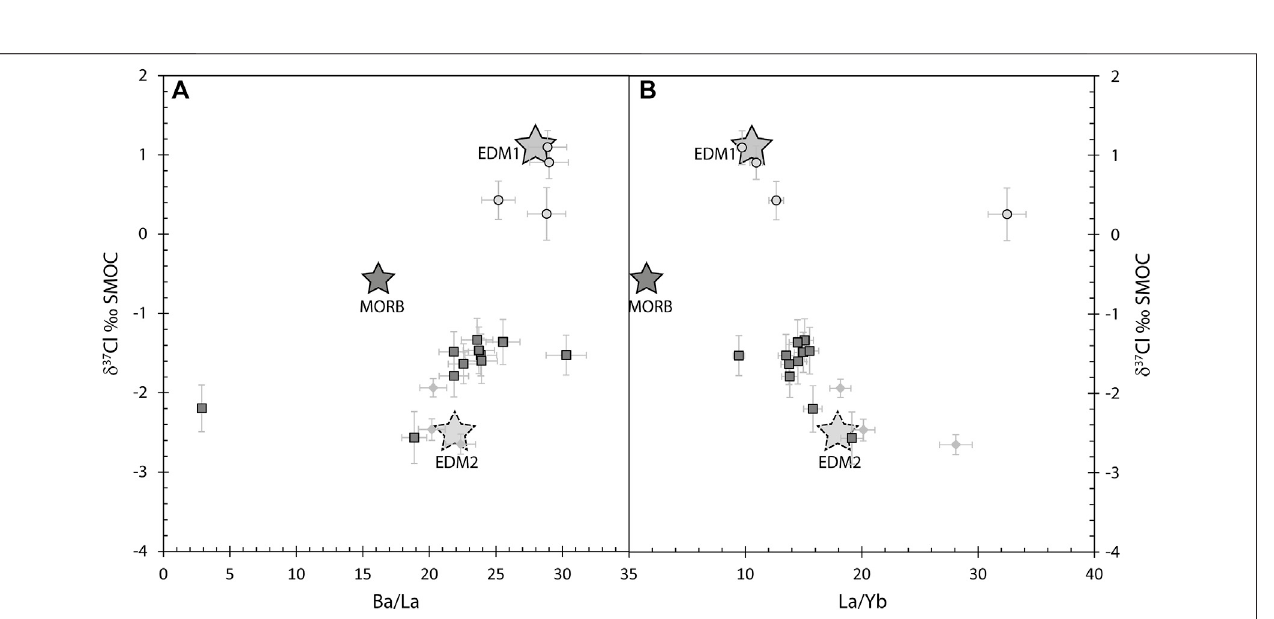
FIGURE 10 | Chlorine isotopes plotted against Ba/La (A) and La/Yb (B) ratios in melt inclusions. EDM1 and high potassium calco alkaline melt inclusions have higherBa/LacomparedtoEDM2,shoshonitic,andpotassicmeltinclusions,whereasEDM2hasahigherLa/YbratiocomparedtoEDM1.EDM1isthusmoreenrichedin fl uid-mobile elements relative to